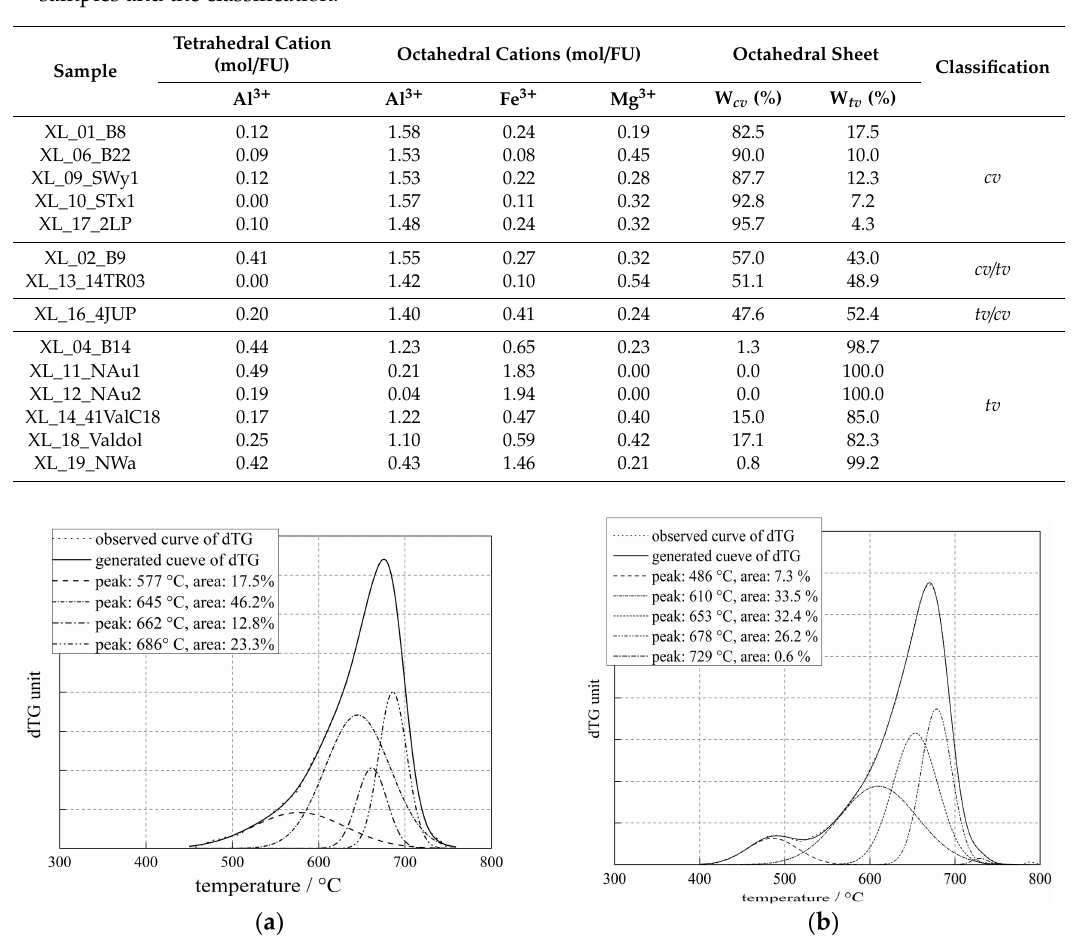
Figure 6. Examples of derivative thermogravimetry (DTG) curves of cv smectites. ( a ) Sample XL_01_B8 with 82.5% of cv layers; ( b ) Sample XL_10_STx1 with 92.8% of cv layers. Samples XL_02_B9 and XL_13_14TR03 can be classified as cv / tv varieties. They had a main peak ◦ above 600 C which indicate one dehydroxylation reaction (Figure 7). Thus, the cv configurations dominated in these two samples (Table 4).